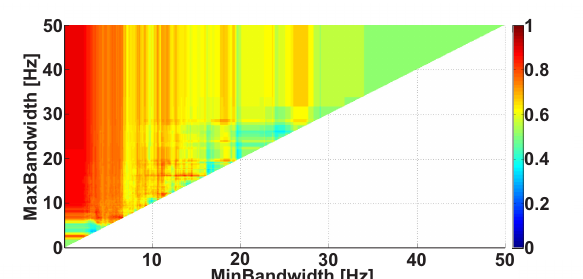
Figure 14. An example of the Bandwidth AUC diagram. The frequency interval of the considered wave trains is from 8 to 20 Hz. The abscissa axis indicates the lower bound of the frequency bandwidth; the ordinate axis indicates the upper bound of the frequency bandwidth. The bright red column corresponds to the frequency bandwidth values of the wave trains that are typical for PD patients.